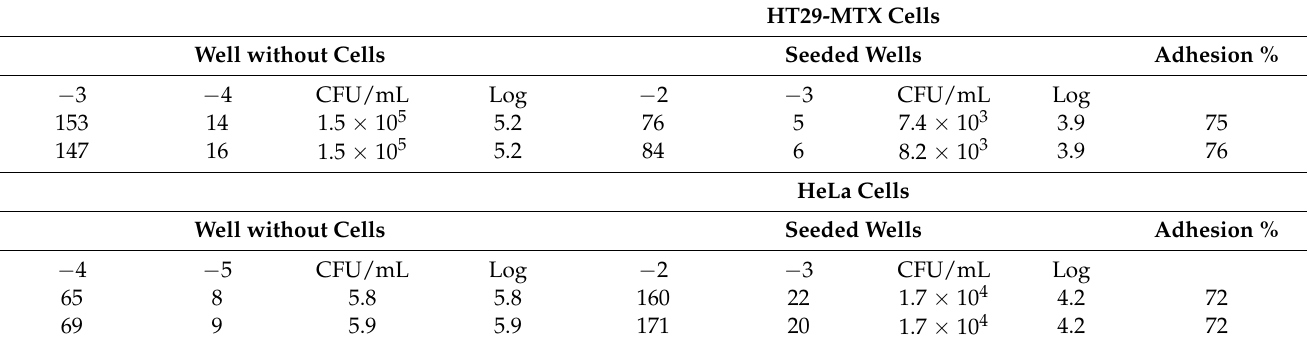
Table 2. Adhesion percentages obtained for L. crispatus M247 on HT29-MTX and HeLa cells. CFU: colony forming